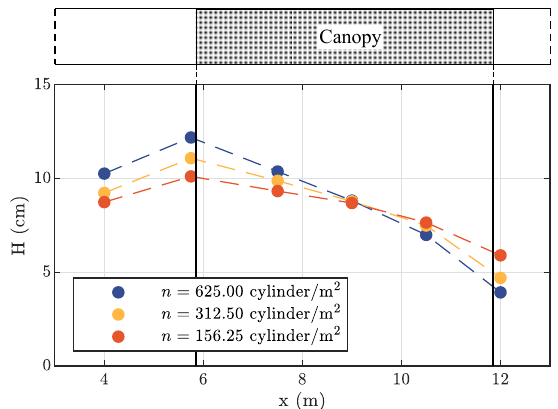
Figure 5. Reduction of the wave height H with different vegetation